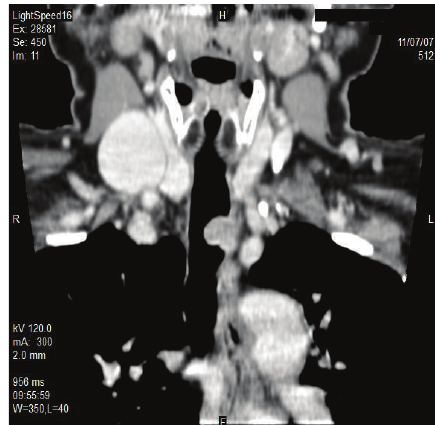
Figure 3: 64-year-old female with granular cell tumor of trachea. Shadedsurfacedisplay(SSD)imageoftracheathatshowstheimpact of mass (black arrow) on trachea lumen (16-slice Multidetector CT, GE Medical